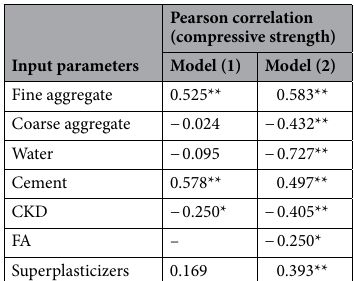
Table 5. Correlations between the input variables and the predicted compressive strength. **Correlation is significant at the 0.01 level (2-tailed). *Correlation is significant at the 0.05 level (2-tailed).